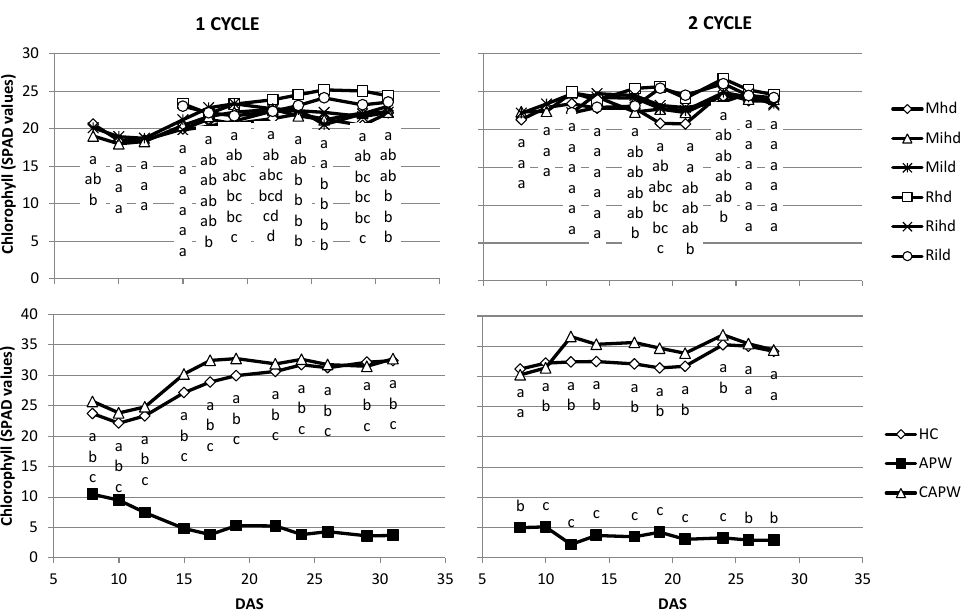
Figure 7. Effect of vegetable species and water treatment on chlorophyll content values over two growth cycles. M HD : mizuna high density; M IHD : mizuna intercropped high density; M ILD : Mizuna intercropped low density; R HD : rocket salad high density; R IHD : rocket salad intercropped high density; R ILD : rocket salad low density; HC: hydroponic control; APW: aquaponic water; CAPW: complemented aquaponic water. Different letters on the same DAS indicate significant differences, with p < 0.05, based on Tukey HSD Test.